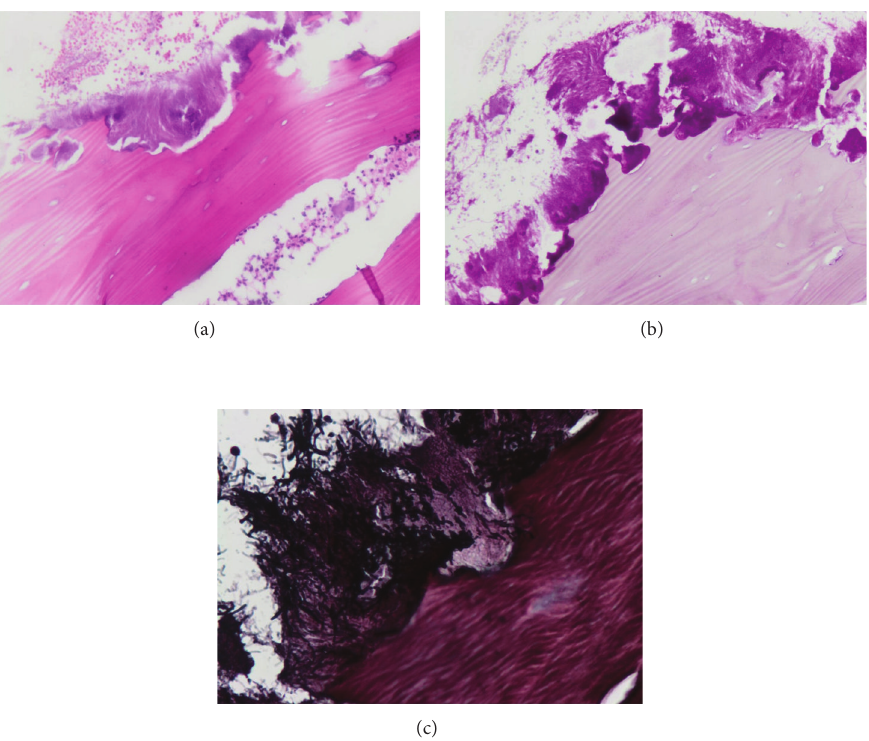
Figure 2: (a) H&E × 100. Necrotic bone trabecula with hyphae and altered polymorphs. (b) PAS × 100 necrotic bone with hyphae. (c) Grocott × 400 hyphae and